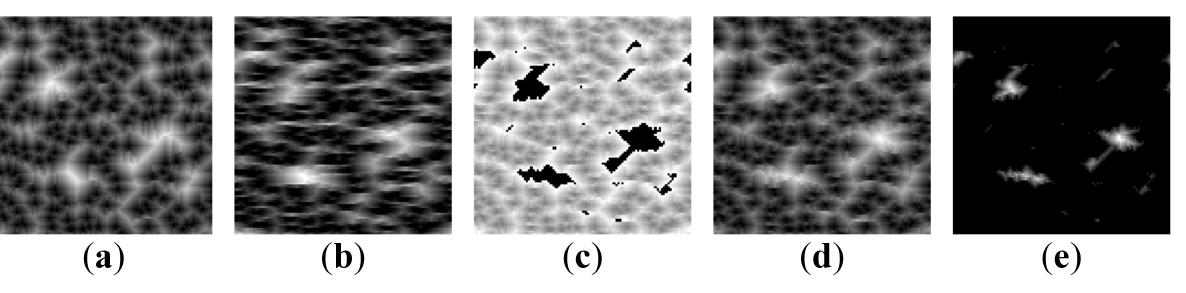
Figure 5. Comparison of self-organizing patterns (SOP) for different values of parameters. ( a ) ν = 0 . 1 , τ = 20 , n = 20 , δ = 0 . 001 ( b ) ν = 0 . 9 , τ = 20 , n = 20 , δ = 0 . 001 ( c ) ν = 0 . 5 , τ = 20 , n = 10 , δ = 0 . 001 ( d ) ν = 0 . 5 , τ = 20 , n = 20 , δ = 0 . 001 ( e ) ν = 0 . 5 , τ = 20